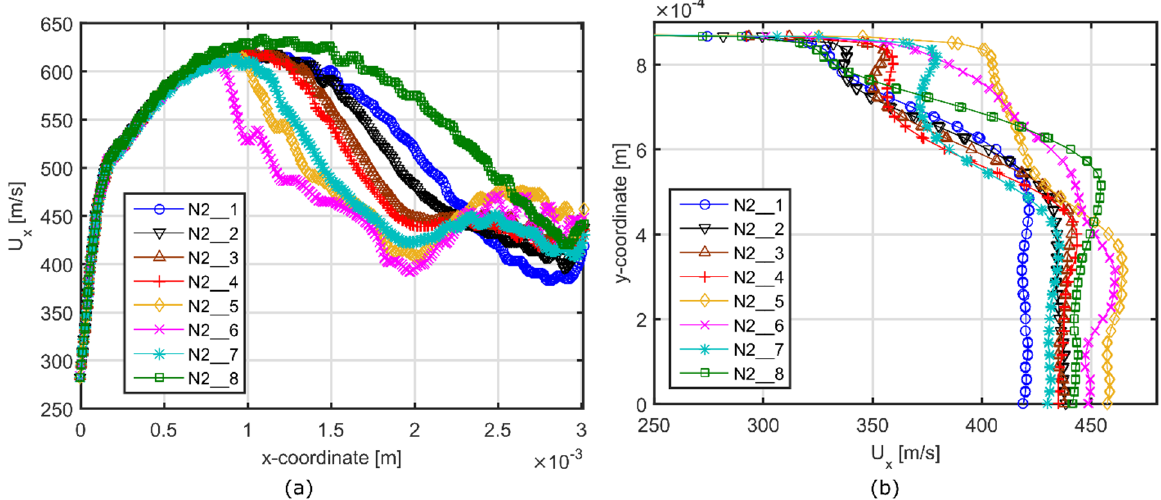
Figure 11. Profiles of the axial velocity U x for the water vapor flow in the symmetry plane (0, x,y ): ( a ) at y = 0 m (along the symmetry axis); ( b ) at x = 0.00301 m (along the width-wise direction). Test cases: N2_1 (baseline); N2_2 (additional mass flow rate, jet 1 = ON, jet 2 = OFF); N2_3 (additional mass flow rate, jet 1 = ON, jet 2 = OFF); N2_4 (additional mass flow rate, jet 1 = ON, jet 2 = ON); N2_5 (additional mass flow rate, jet 1 = ON, jet 2 = OFF); N2_6 (additional mass flow rate, jet 1 = ON, jet 2 = ON); N2_7 (bypassed mass flow rate, jet 1 = ON, jet 2 = OFF): N2_8 (additional mass flow rate, jet 1 = OFF, jet 2 = OFF).